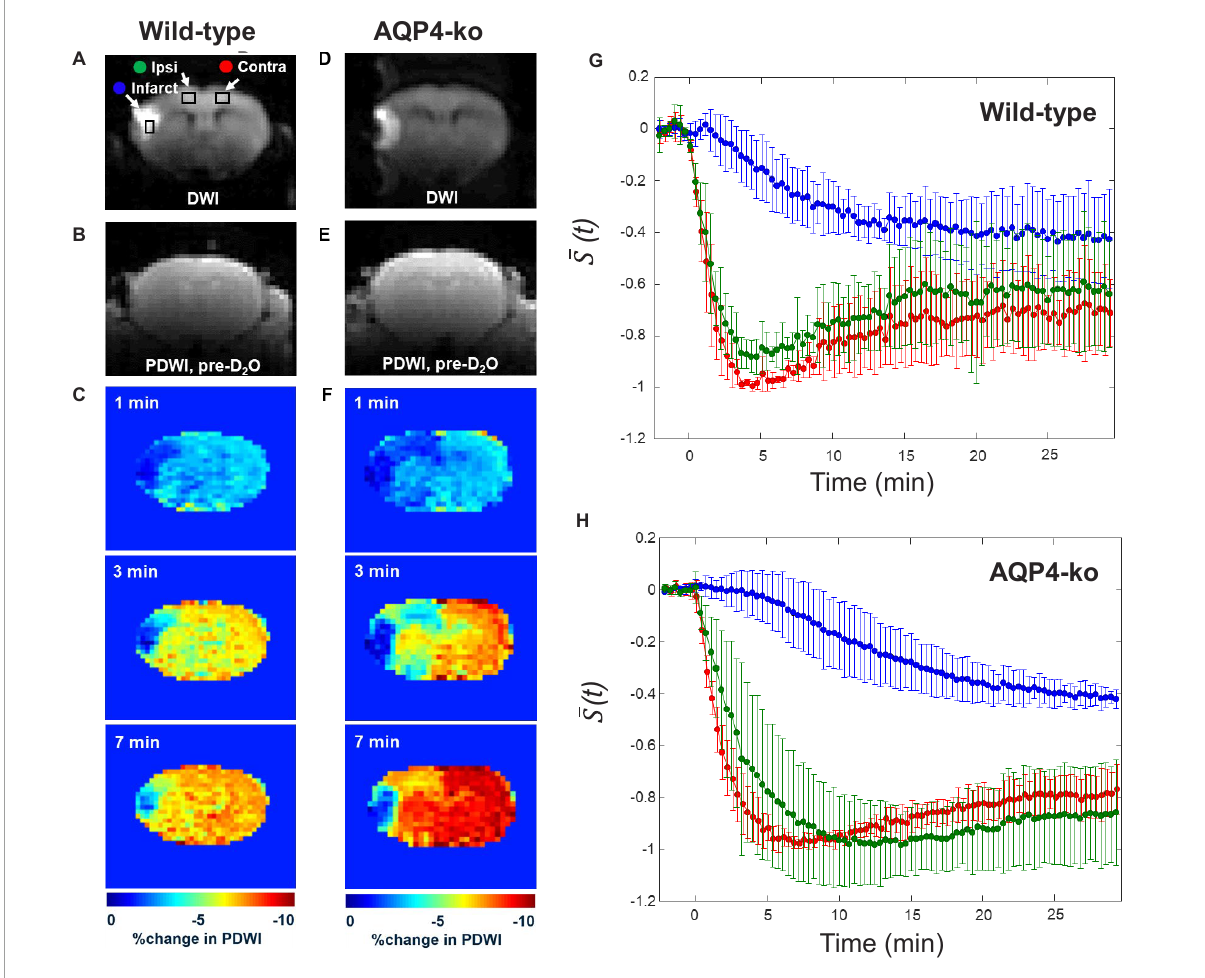
FIGURE2 Water dynamics measurements after intraperitoneal administration of deuterium-labeled water (D 2 O). (A–C) Representative diffusion-weighted imaging (DWI) images, pre-D 2 O baseline proton-density-weighted imaging (PDWI) images and % signal change at 1, 3, and 7 min after D 2 O administration for the wild-type mice. (D–F) A similar set of images for the AQP4 knockout (AQP4-ko) mice. (G) Standardized signal changes in each region-of-interest (ROI) for the wild-type mice. (H) Standardized signal changes in each ROI for the AQP4-ko mice. Error bars indicate standard deviations across animals. The Infarct (blue), Ipsi-anterior cerebral artery (ACA) (green), and Contra-ACA (red) ROIs are shown on the DWI image in panel (A)